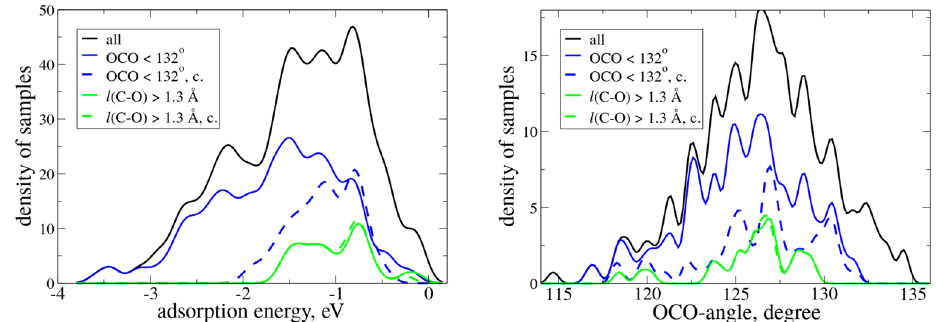
Fig. 2 Distribution of adsorption energies (left) and OCO-angles (right). The distribution is shown for the whole dataset (black), for the top subgroups of sites with OCO < 132° angles (blue) and l (C – O) > 1.30 Å (green). The subgroups obtained with adsorption energy constraint are marked with “ c. ” and shown with dashed lines. The adsorption energy E ads is de fi ned as the difference between the total energy of the slab with adsorbed CO 2 and the sum of total energies of the clean slab and an isolated CO